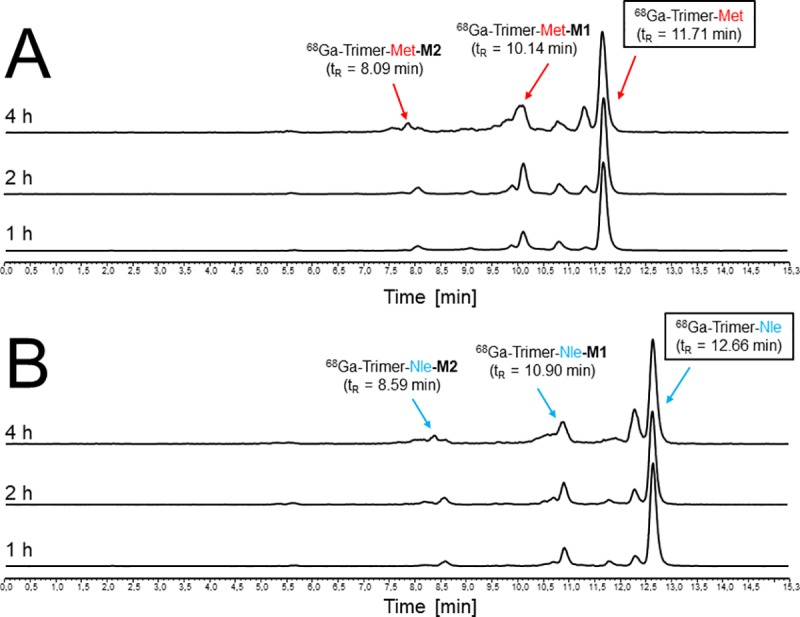
In vitro stability assessment of 68Ga-labelled trimers in fresh human serum.Radio-RP-HPLC analysis of the supernatant of 68Ga-labelled trimeric Met- (A) and Nle (B) conjugates incubated in fresh human serum. Major degradation products representing in vitro metabolites are assigned with arrows.